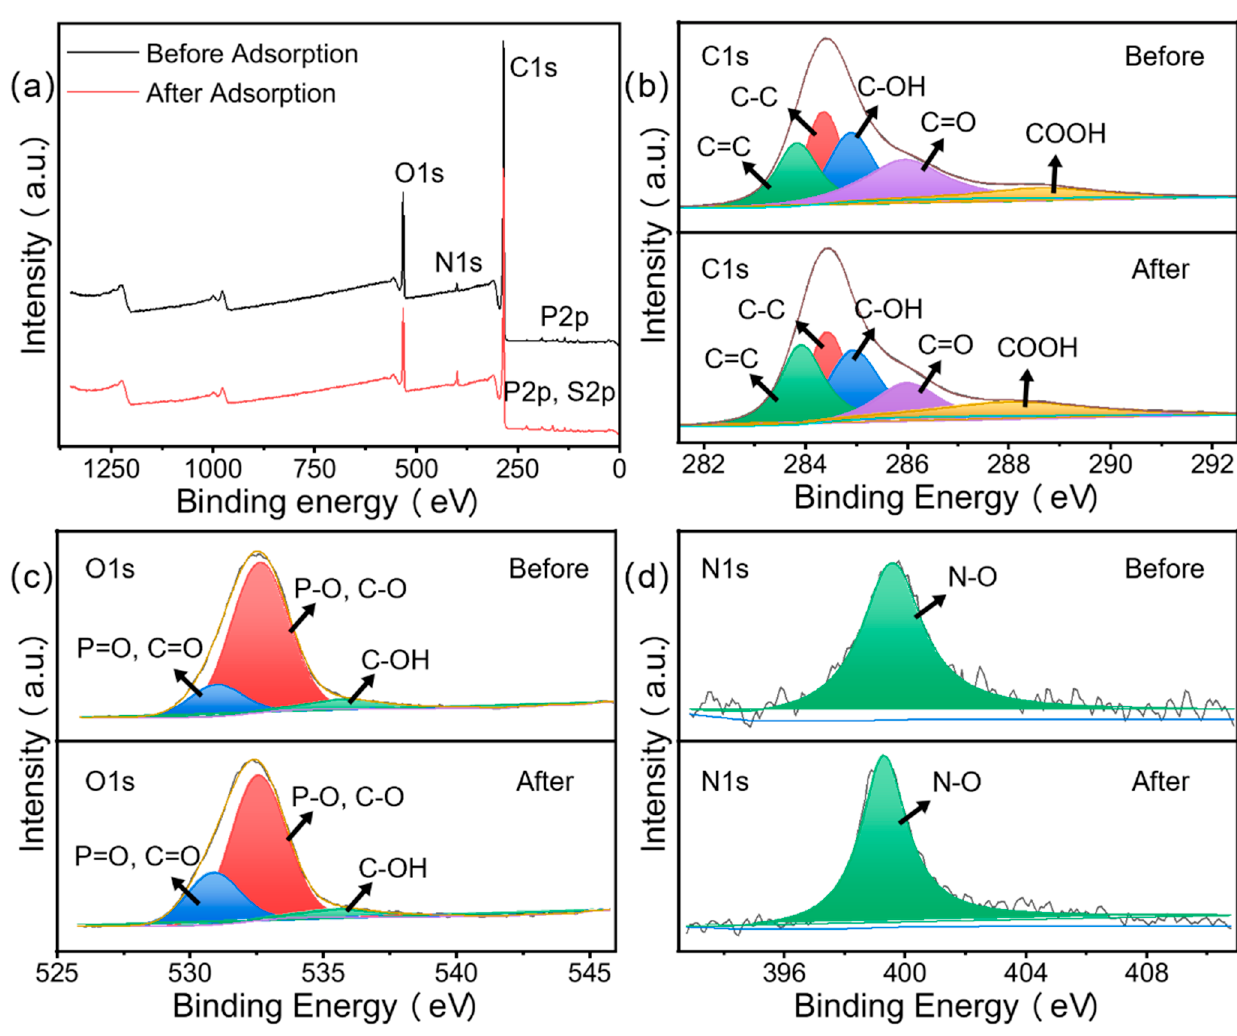
Figure 7. XPS full spectra of ( a ) CN, ( b ) C 1s, ( c ) O 1s, and ( d ) N